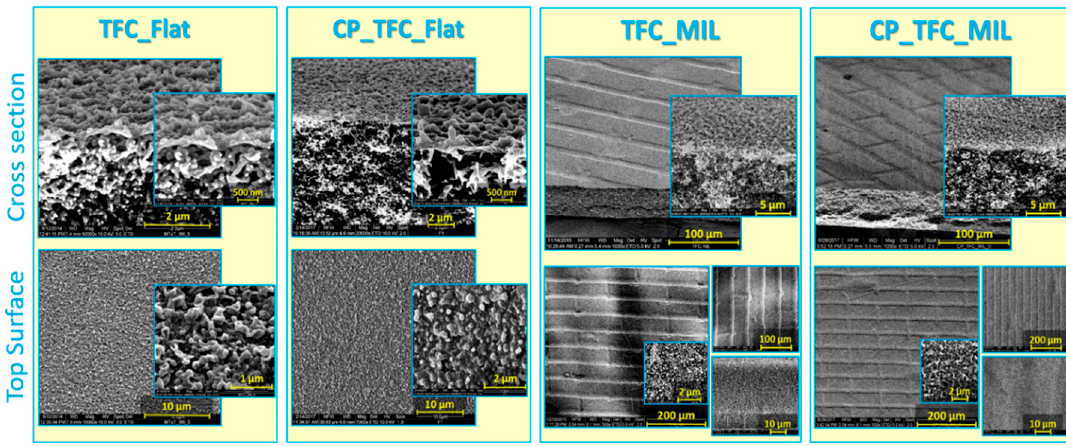
Figure 1. SEM micrographs of top surface and cross-section morphologies at different magnifications for flat vs. micro-patterned surface modified (“CP”) and pristine polyamide (PA) thin-film composite (TFC) membranes.